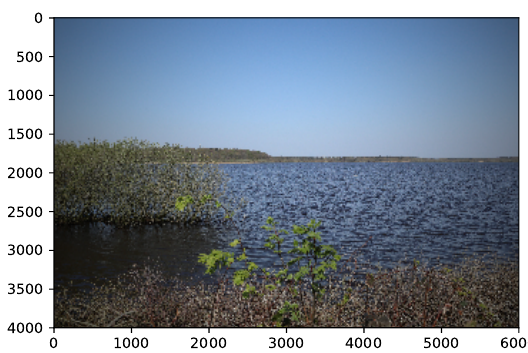
Fig. 11.— Holiday snap with cxslearly visible vignetting